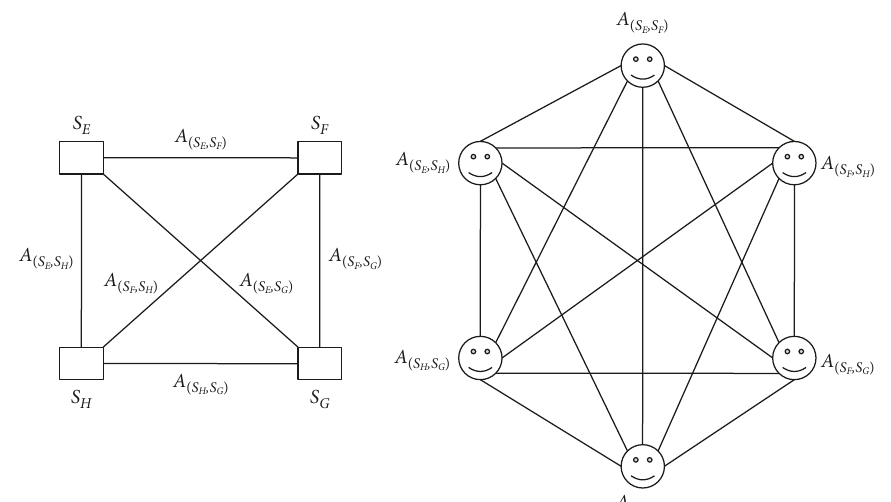
Figure 2: A graph construction for 4 smart cities services where services are associated with edges (left) or with vertexes